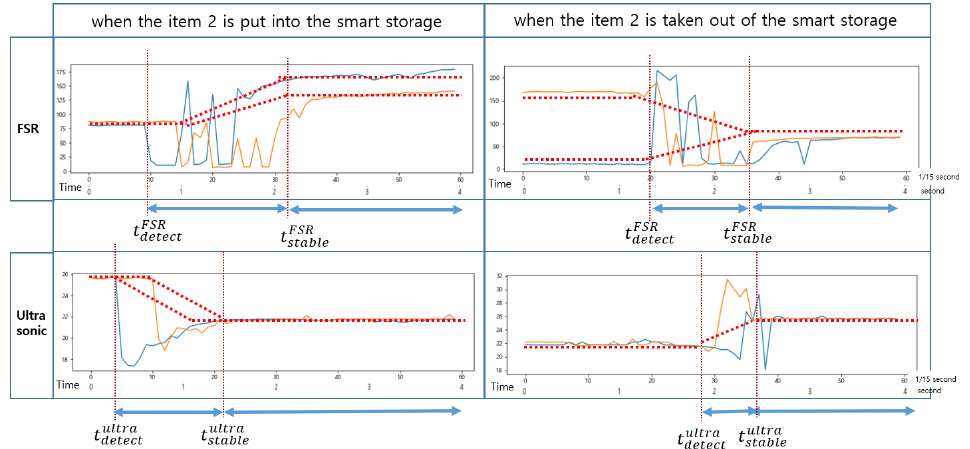
Figure 18. Changes in the sensed values of the FSR sensor and the ultrasonic sensor when item 2 was put in and taken out of the smart